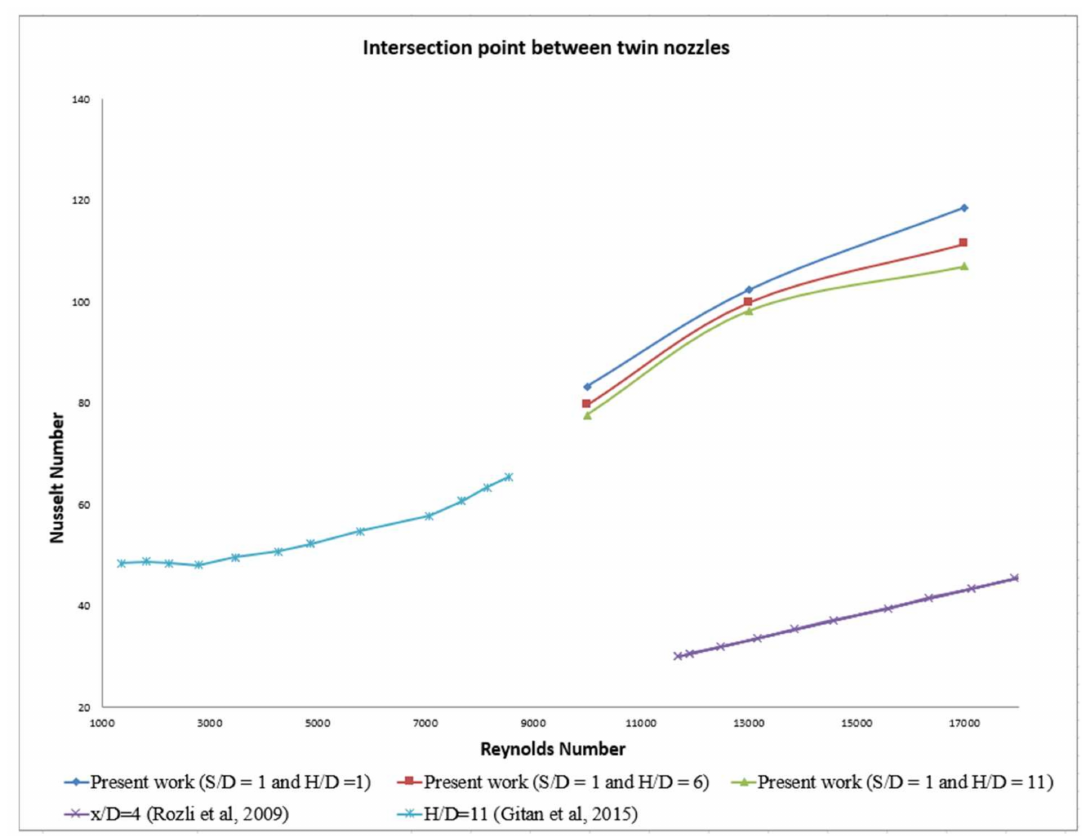
Figure 7. Interaction of the Nusselt Number (Nu) and Reynolds number at nozzle-plate distance = 1, 6, 11 cm and Nozzle-Nozzle spacing = 1